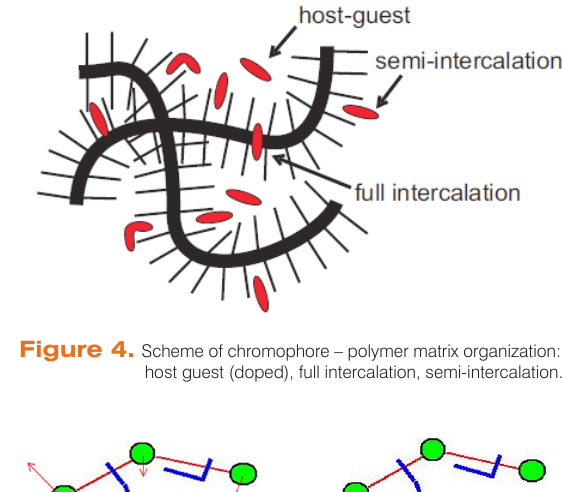
Figure 5. Semi-intercalated DR1 chromophore with one end rigidly attached to the bond (backbone of the polymer) follows the motion of this bond resulting from the movements of the monomers (left). DR1 chromophore in an immobile matrix preserves the orientation of trans isomer in the space